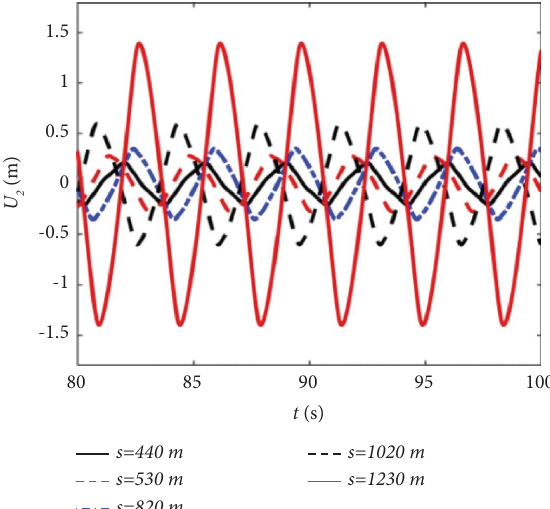
Figure 17: Time history of total tension.